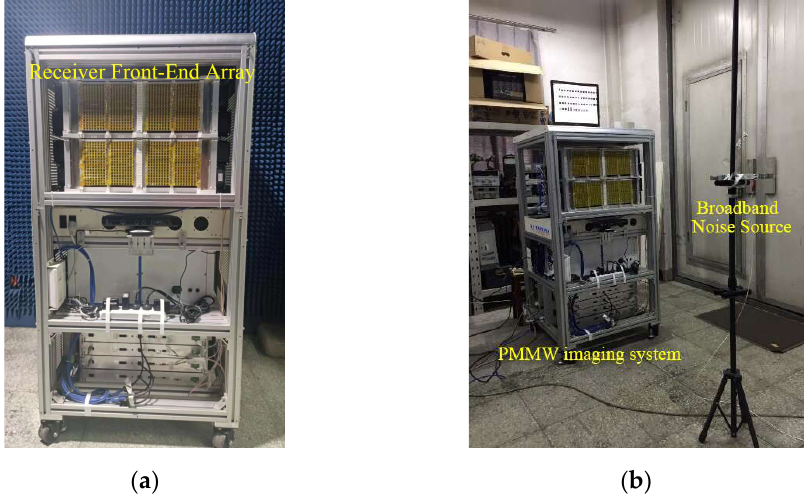
Figure 26. ( a ) The assembled 1024-channel PMMW imaging system. ( b ) The spatial resolution meas-